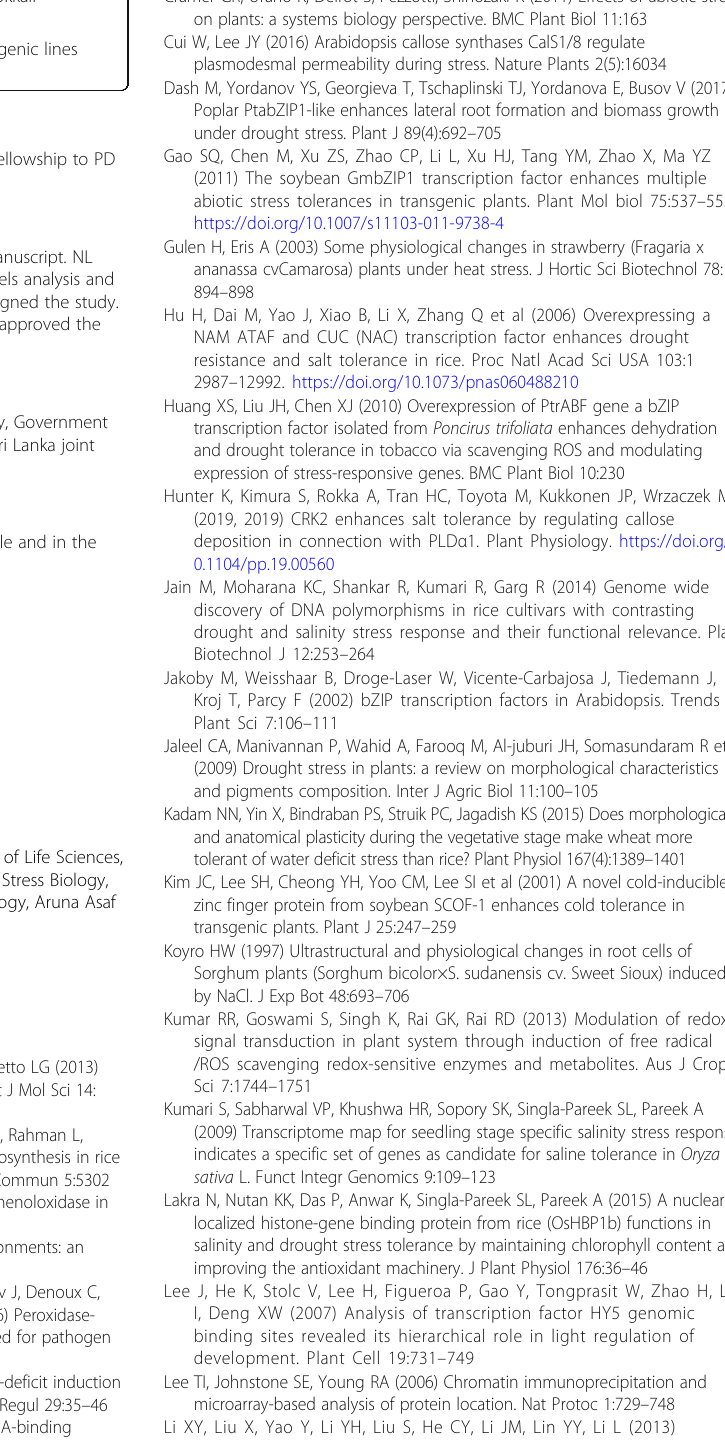
Additional file 5: Table S1. List of primers used in this study and their sequences (5 ′ to 3 ′ ). (DOCX 16 kb) Additional file 6: Table S2. SNPs and InDels analysis of Saltol QTL localized gene OsHBP1b (LOC_Os01g17260) in IR64 and Pokkali genotypes of Oryza sativa L. (DOCX 21